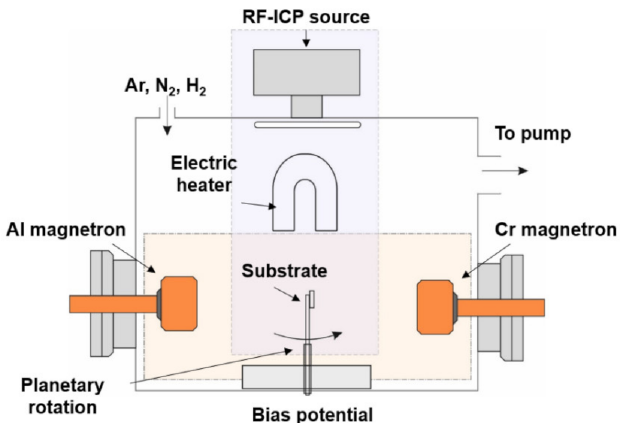
Figure 1. Scheme of the experimental installation for the duplex